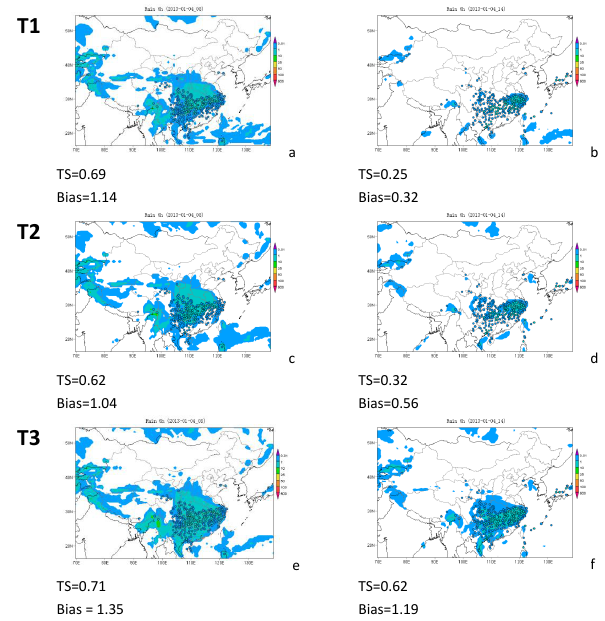
Figure 6. Panel (a) shows the distribution of 6h accumulated pre- cipitation (shaded) compared with observations (dotted) with the TS and bias at 08:00LT 4 January 2013 by T1. Panel (b) is the same as (a) but for 14:00LT; (c) is the same as (a) but for T2, and (d) is same as (c) but for 14:00LT. (f) is the same as (a) but for T3, and (f) is the same as (e) but for